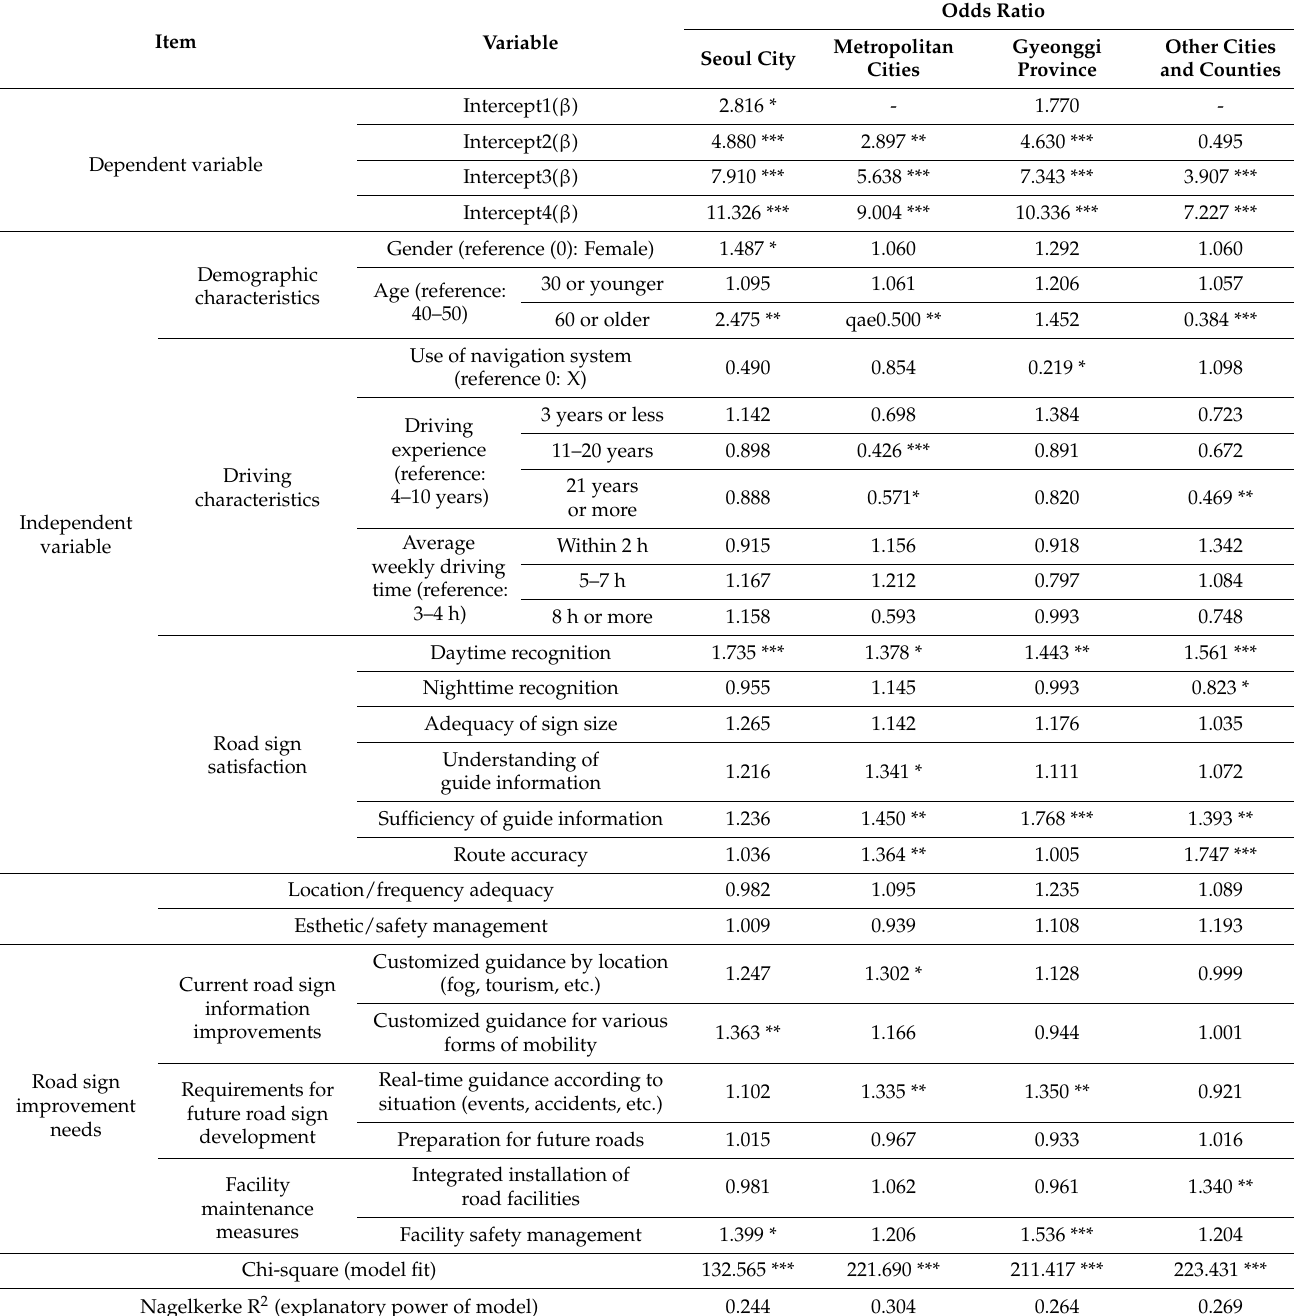
Table 7. Analysis results with respect to city